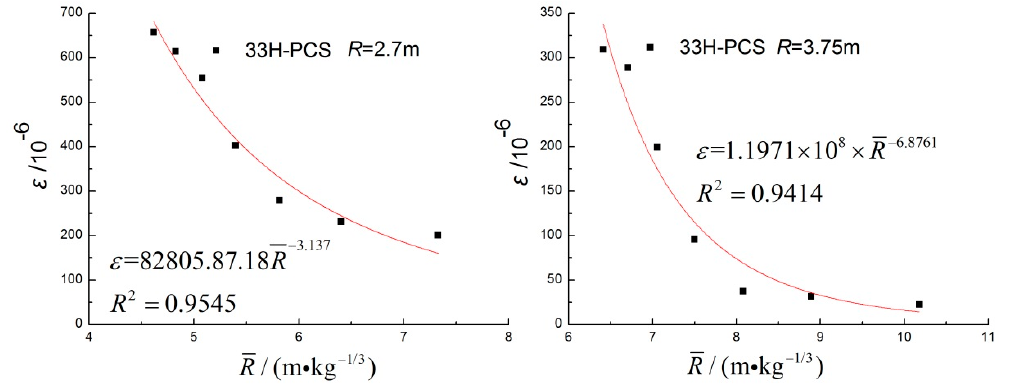
Figure 10. The PCS of 33H ( R = 2.7 m or R = 3.75 m).